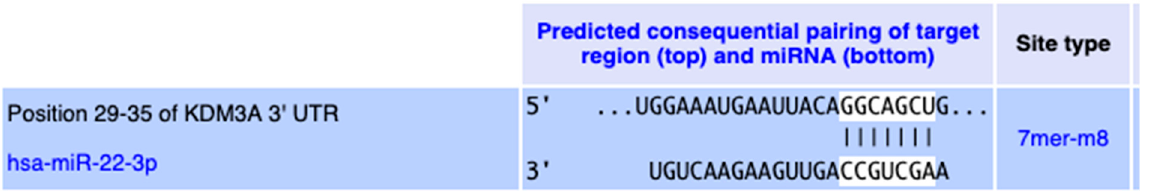
Figure 3. Conserved interaction between hsa-miR-22-3p and the 3 ′ -UTR region of the KDM3A gene (TargetScanHuman 8.0, www.targetscan.org/vert_80/ (accessed on 20 February 2023)). The expression of KDM3A is widely distributed across human tissues and organs with low tissue speci fi city of 0.29 (www.proteinatlas.org/ (accessed on 20 February 2023).